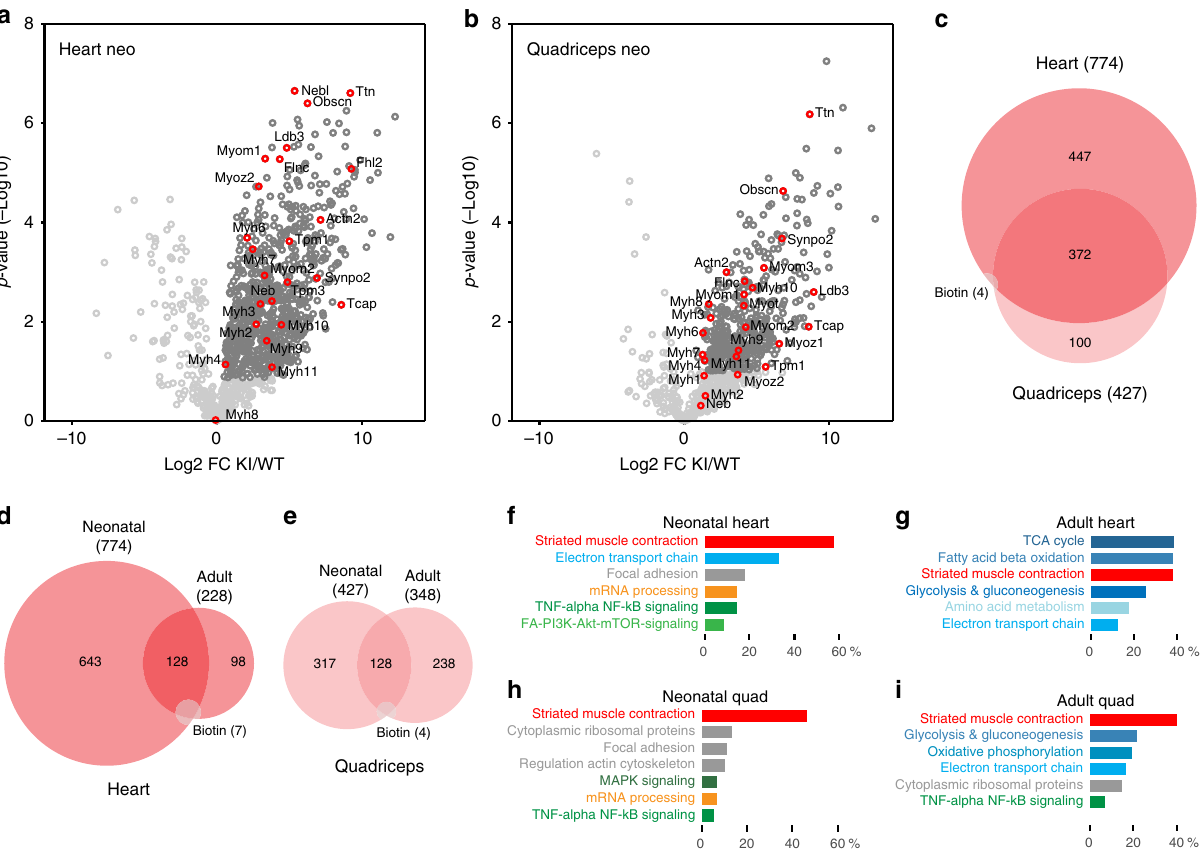
Fig. 5 The sarcomeric neonatal vs. adult proteome. Proteins that co-purify with biotinylated proteins after streptavidin pulldown of neonatal TiZ-BioID knock-in vs. WT heart ( a ) and quadriceps ( b ) link to partially overlapping signaling and metabolic pathways in the heart and skeletal muscle. Known sarcomeric proteins in red, signi fi cantly enriched in dark gray. c The neonatal sarcomeric proteome comprises >850 proteins, >350 shared between the heart and quadriceps. The transition from neonatal to adult involves a major switch in expression of sarcomere-associated proteins in the heart ( d ) and quadriceps ( e ). f – i Wikipathway analysis (% genes per term). The majority of sarcomere-associated proteins relates to striated muscle contraction (red) with a shift from structural (gray) and signaling pathways (green) to metabolism (blue) in the adult. In neonatal and adult quadriceps, ribosomal proteins are enriched ( h , i ), mTOR signaling is speci fi c to the neonatal heart ( f ) vs. MAPK signaling in quadriceps. NF- κ B signaling is enriched in all neonatal and quadriceps tissues ( f , h , g ). Source data are provided as a Source Data fi